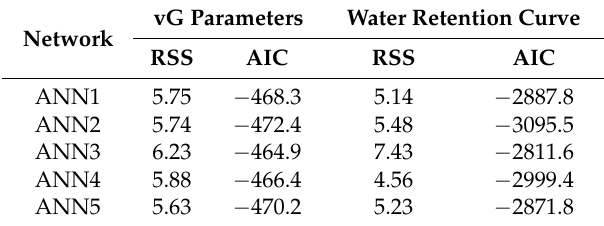
Table 6. Akaike’s information criterion (AIC) test of efficiency of ANNs in modeling van Genuchten (vG) parameters and water retention curve values. RSS—residual sum of